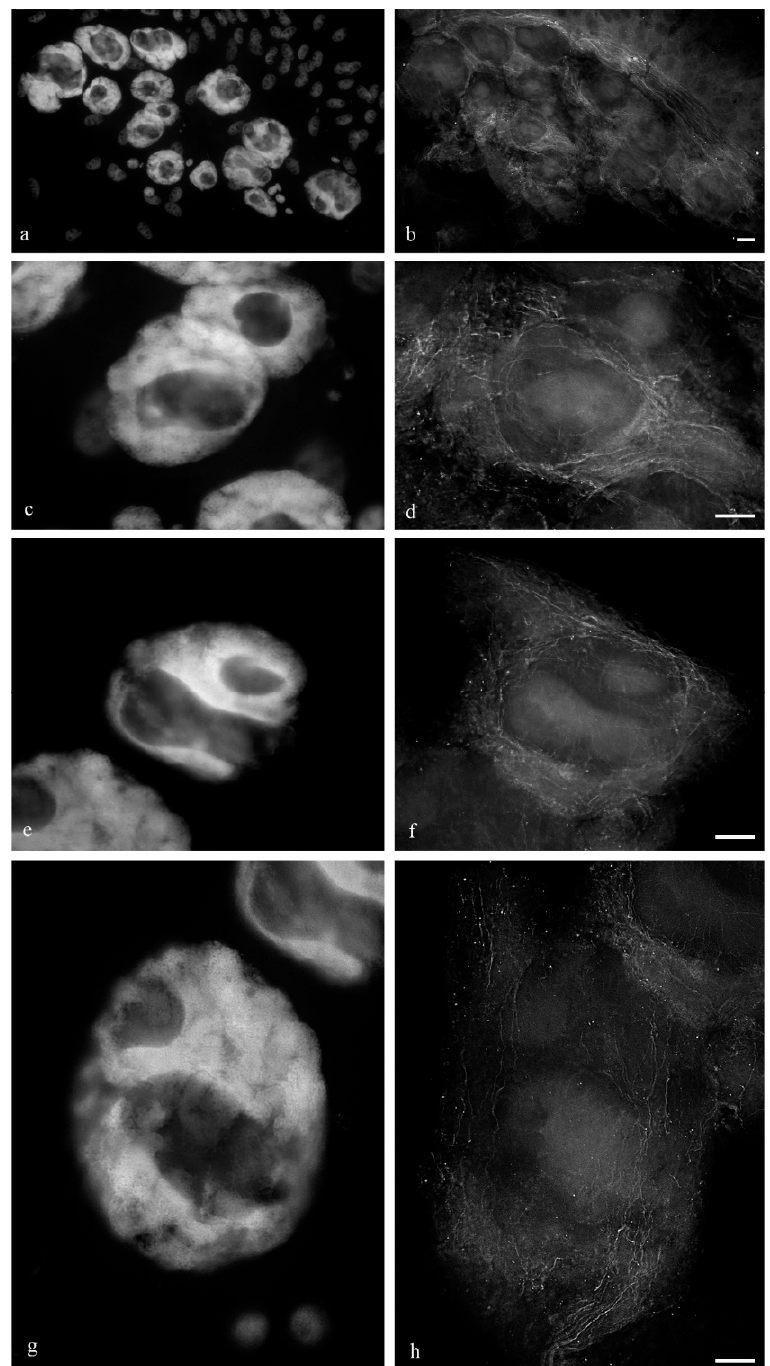
Figure 12. Actin filaments of the cytoskeleton of the cytoplasm of the antipodal cells of the wheat embryo sac at the early and medium stages of differentiation. Microfilaments surround the nuclei of the antipodal cells of the complex ( a ) and are detected between vacuoles and on the periphery of the cytoplasm ( b ). Microfilaments of the individual antipodal cells of the complex ( c , e , g —DAPI); actin filaments ( d , f , h ). The scale is 10 µm.